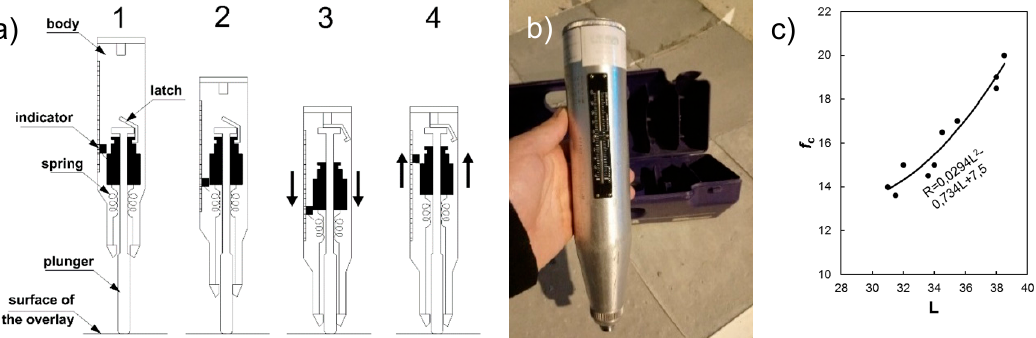
Figure 7. The scheme of the sclerometric method (a), the view of the testing device (b), and the typical relation (c) between the rebound number and compressive strength (based on References [19,20]).